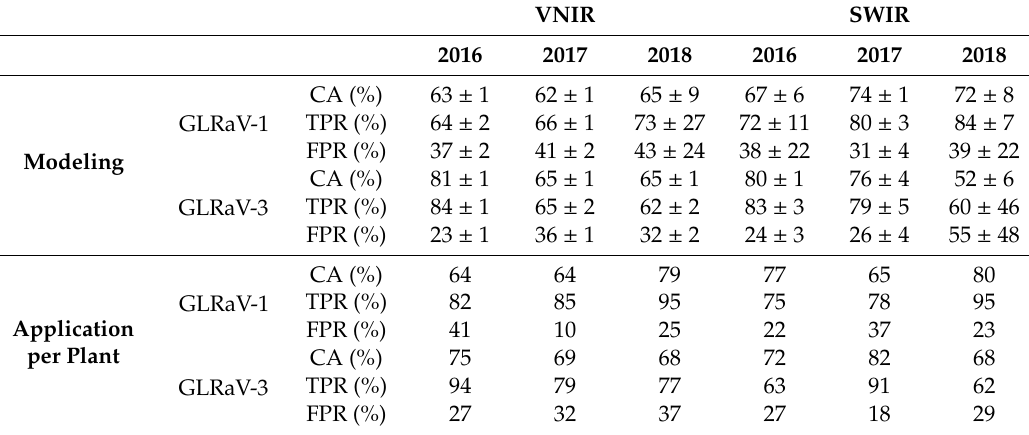
Table 10. Results for the in-field detection of GLRaV-infected but symptomless grapevines. For modeling, all pixels were evaluated not considering spatial scales. Developed models were then applied per plant using all leaves for majority voting. VNIR SWIR